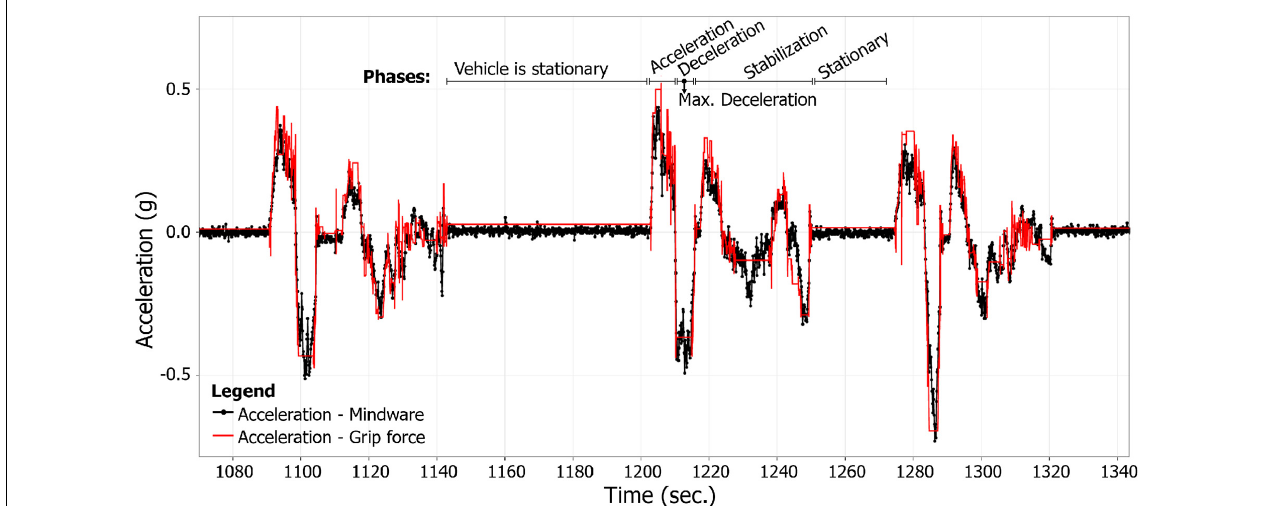
FIGURE 3 | Synchronized acceleration vectors of both accelerometers (of the Mindware system—in black—and the self-developed grip force measurement system—in red) in the direction of the vehicle’s travel, during three successive experimental driving sessions, of a single